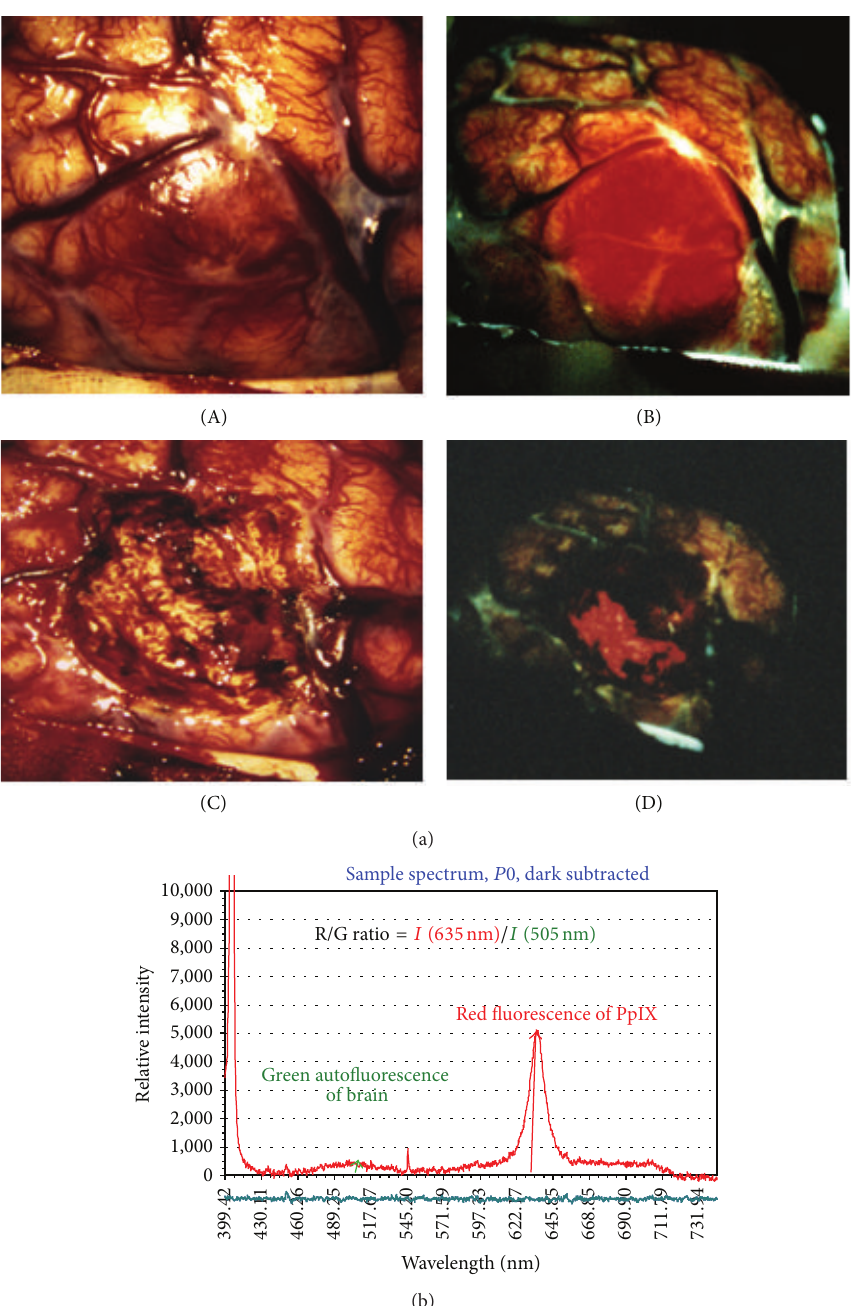
Figure4:(a)Anintraoperativephotographofthebrainsurface.(A)Thetumorsurfaceunderxenonwhitelight.Hypervascularityisobserved; however, the tumor boundary is vague. (B) By irradiating excitation light of violet-blue, red fluorescence from the tumor tissues is observed and the tumor boundary is clearly recognized. (C) In the cavity after tumor removal under xenon white light, the residual tumor is not clearly recognized. (D) In the same operative field as (C) under excitation light of violet-blue, the residual tumor is clearly recognized. (b) The R/G ratio with fluorescence spectrum. We obtained the amplitude of the red (R) PpIX fluorescence from the glioma tissues and the green (G) autofluorescence from the glioma tissues in a